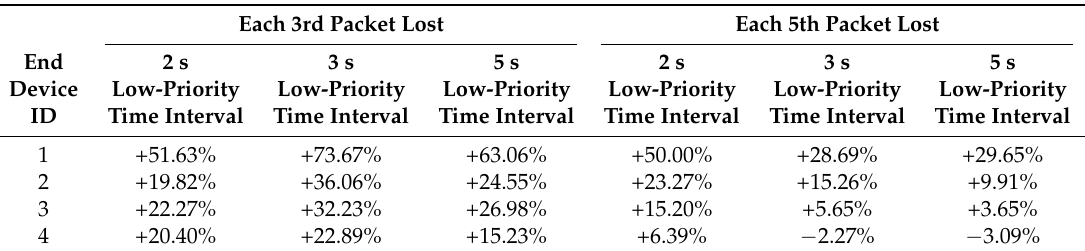
Table 7. Comparison of the two simulation modes for congestion conditions. Each 3rd Packet Lost Each 5th Packet Lost